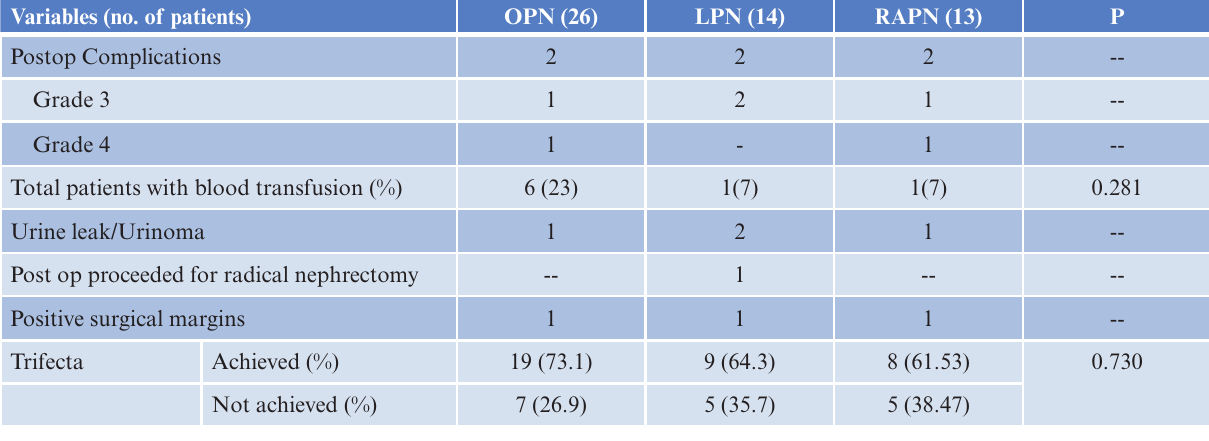
Table 2: Complications and TRIFECTA Variables (no. of